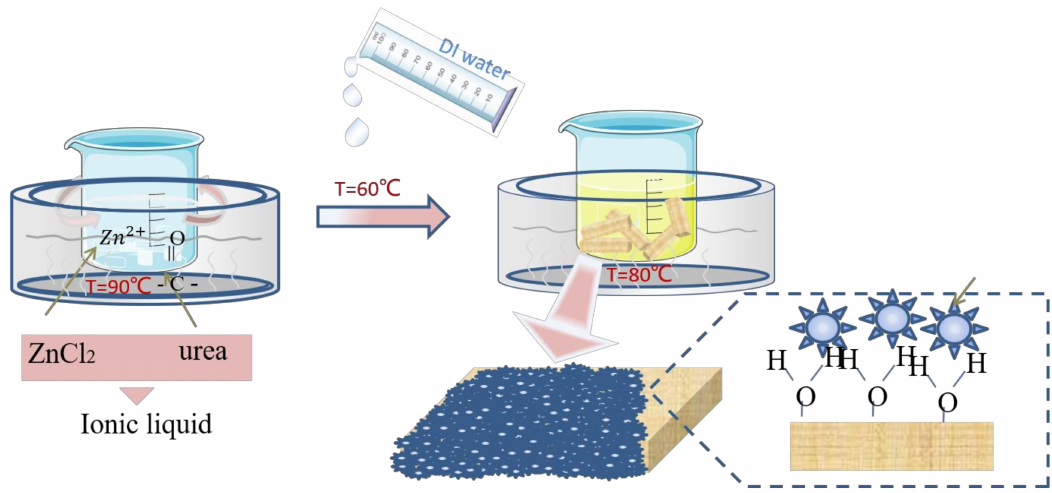
Figure 1. The preparation process of ionic liquid (IL) and nano-Zinc complex coated